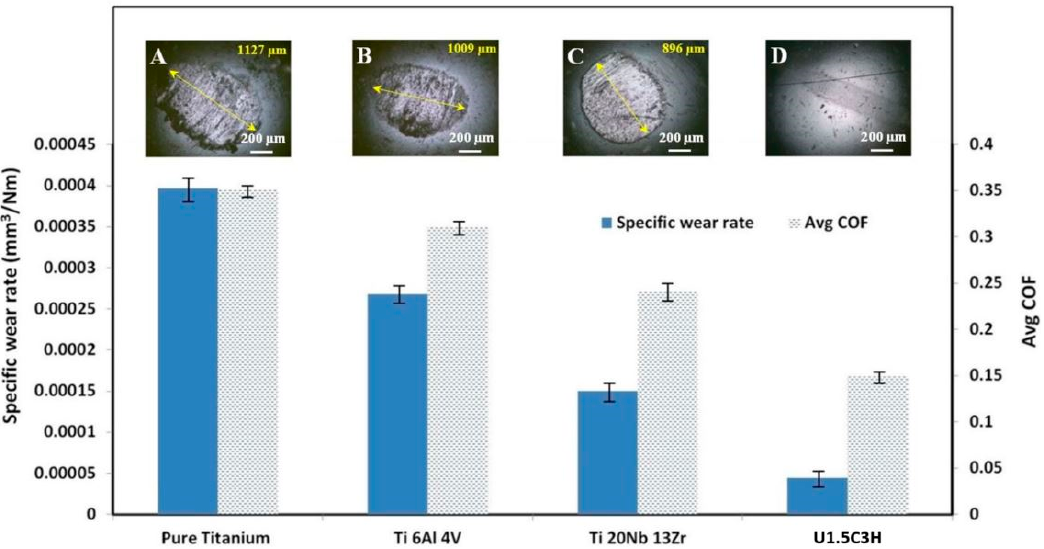
Figure 15. Specific wear rates/coefficient of friction for bare substrates and the hybrid nanocomposite coating tested under at a normal load of 12 N and a sliding velocity of 0.1 m/s. ( A ) Pure Titanium; ( B ) Ti6Al4V; ( C ) Ti20Nb13Zr; ( D ) U1.5C3H.